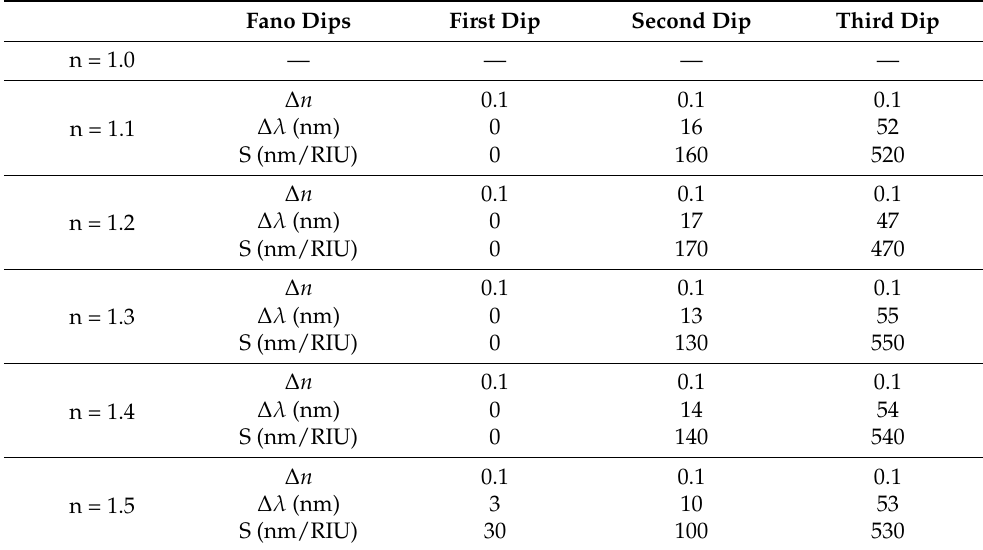
Table 1. Sensitivity of the nanostructure for different refractive indexes. Fano Dips